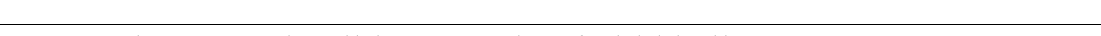
Fig. 2 Pre-HSCs and progenitors are discernible by opposing gradients of endothelial and haematopoietic transcripts in E11 IAHCs. a t-SNE map of 554 single cells isolated from E11 embryo AGM and yolk sac (YS). a (left panel) t-SNE map displaying 27 sorted non-haemogenic endothelial cells (non-HE cells, Cdh5 + G fi 1 − c-kit - , brown dots), 45 haemogenic endothelial cells (HE cells, Cdh5 + G fi 1 + c-kit − , green dots), 43 cells undergoing endothelial-to- haematopoietic transition (EHT cells, Cdh5 + G fi 1 + c-kit + , purple dots), 282 IAHC cells (turquoise dots; c-kit + cells in silico puri fi ed based on Gpr56 expression from Fig. 1a), and HSC precursors (58 pre-HSCs type I [c-kit + Cdh5 + , index CD45 − , pink dots] and 55 type II [c-kit + Cdh5 + , index CD45 + , violet dots]) from AGMs. 44 c-kit + cells were also sorted from YS (haematopoietic stem and progenitor cells, HSPCs, khaki dots). a (right panel) Pseudotime analysis by Monocle algorithm of the cells shown in a (left panel) (same color code). b Top panel, proportion of each cell type shown in a along pseudotime; Bottom panel, endothelial and haematopoietic marker gene expression along pseudotime ( vWF [ von Willebrand factor ], Cdh5 [ VE-cadherin ], Kit , Runx1 , Mpo [ Myeloperoxydase ], Mt1 [ Metallothionein 1 ]). c Number of signi fi cantly differentially expressed genes along pseudotime. d t-SNE plot displaying the single cells shown in a in clusters identi fi ed by RaceID analysis. e DE-Seq analysis showing the differential gene expression between type I and type II pre-HSCs (36 genes were signi fi cantly differentially expressed, red dots). f Fluorescence intensity of markers used to sort pre-HSCs along pseudotime (PTPRC [CD45], CDH5, c-kit). g – i E11 embryo cryosections hybridized with smFISH probes against Gpr56 (red dots) ( g – i ) and Mpo (green dots) ( g , h ) or Vwf (green dots) ( i ). IAHC cells ( Gpr56 + ) expressing high (asterisk) or low/no levels (arrow) of Vwf in ( i ). Dash lines delimitate the position of the aortic endothelium and IAHC cells. Dapi marks the nuclei